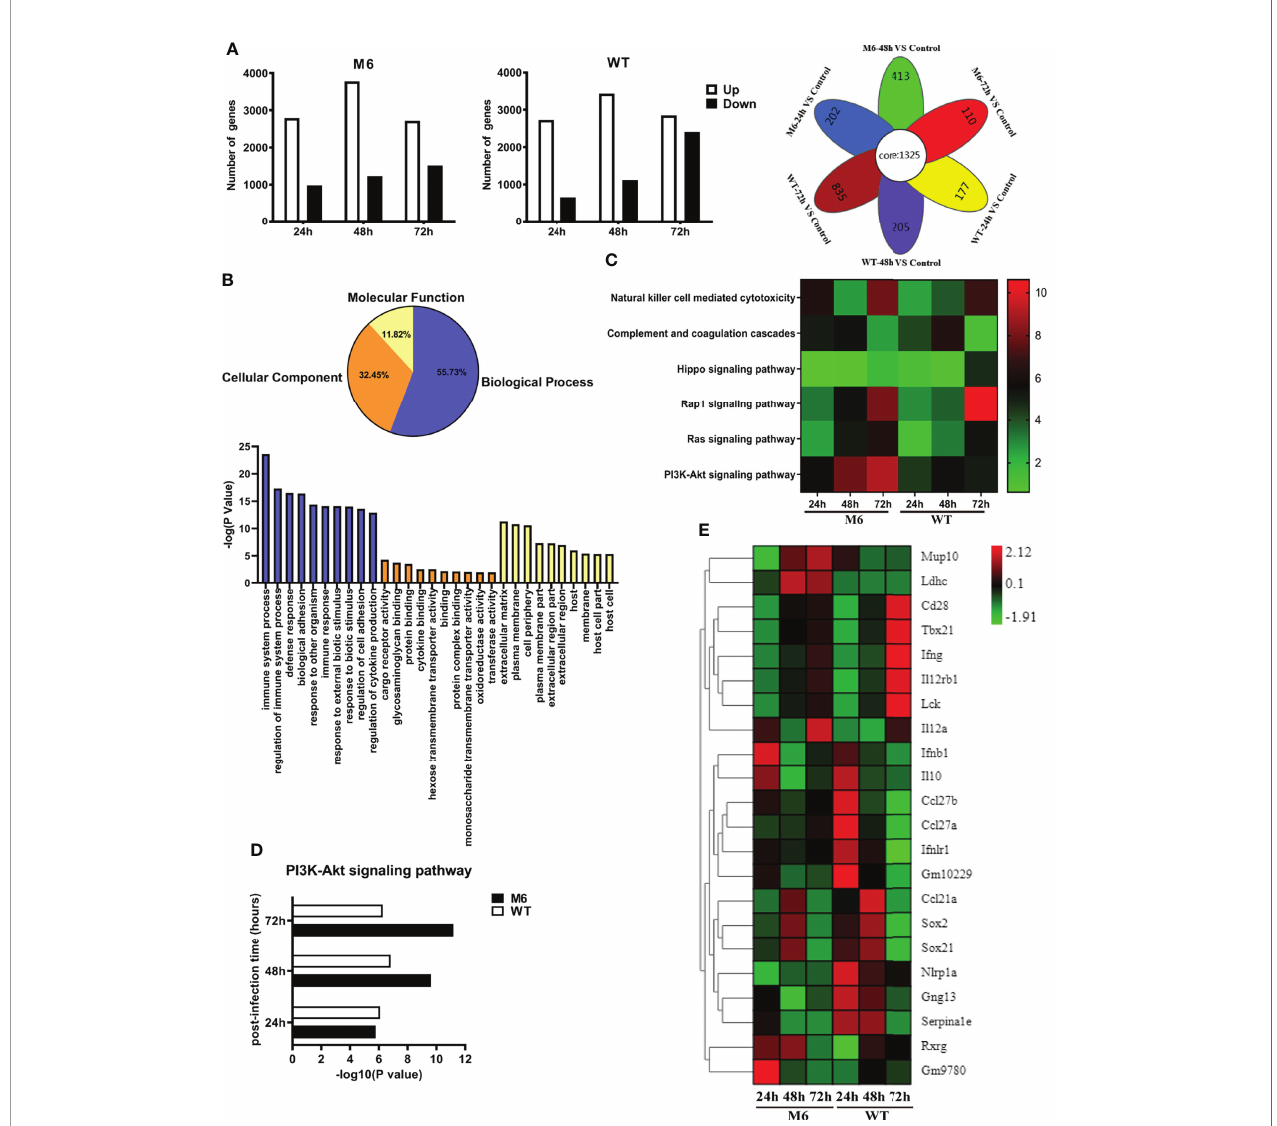
FIGURE 5 | The change in the transcriptional pro fi le of CD103 + dendritic cells infected with the wild-type strain and attenuated M6 strain. (A) The number of signi fi cantly differential genes in dendritic cells infected with M6 and WT. All the data of infected samples were compared with those of the control group (blank DCs without viral infection). The white square represents upregulated genes, and the black represents downregulated genes. The image on the right shows the Venn diagram of the differential genes of M6 and WT infection DCs at different times. The overlapping differentially expressed genes are shown as “ core ” between the M6- infected and WT-infected groups during the entire sampling period (24, 48, and 72 hpi). (B) Gene Ontology enrichment terms for differential genes in dendritic cells infected with M6 and WT, compared with the control group. Blue represents the analysis of biological progress, light yellow represents the analysis of molecular function, and orange represents the cellular component analysis. The histograms represent the number of GOs annotated as unique GO terms and presented in the below panel. (C) The pathways involved in immune-related differential gene expression for M6 and WT compared with the control group. Each row represents a pathway, and the samples are depicted in the columns. Red indicates the numbers of the differentially expressed genes in the more pathways, and green denotes those of the differentially expressed genes in the pathways that were less than the control. (D) Compared with the control, the number of signi fi cant differential genes involved in PI3k-Akt pathways after M6 and WT infection of dendritic cells. (E) Fold changes in the expression of differential genes in infected dendritic cells at different times compared with the control. A heat map and supervised hierarchical clustering analysis revealed 22 genes associated with T and B cells activation. Each row represents a gene, and the samples are depicted in the columns. Red indicates genes expressed at higher levels, and green denotes genes expressed at lower levels. The color bars represent log 2 of fold